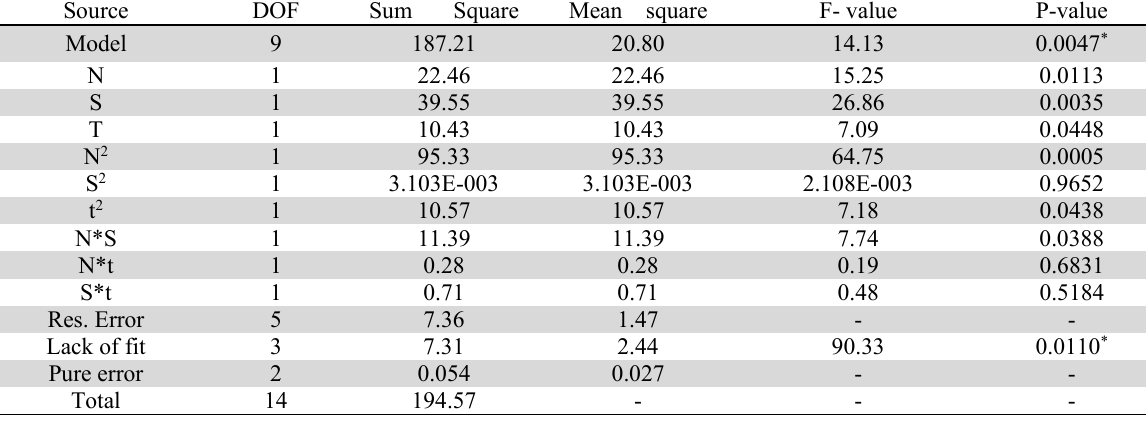
ANOVA table for tool vibration